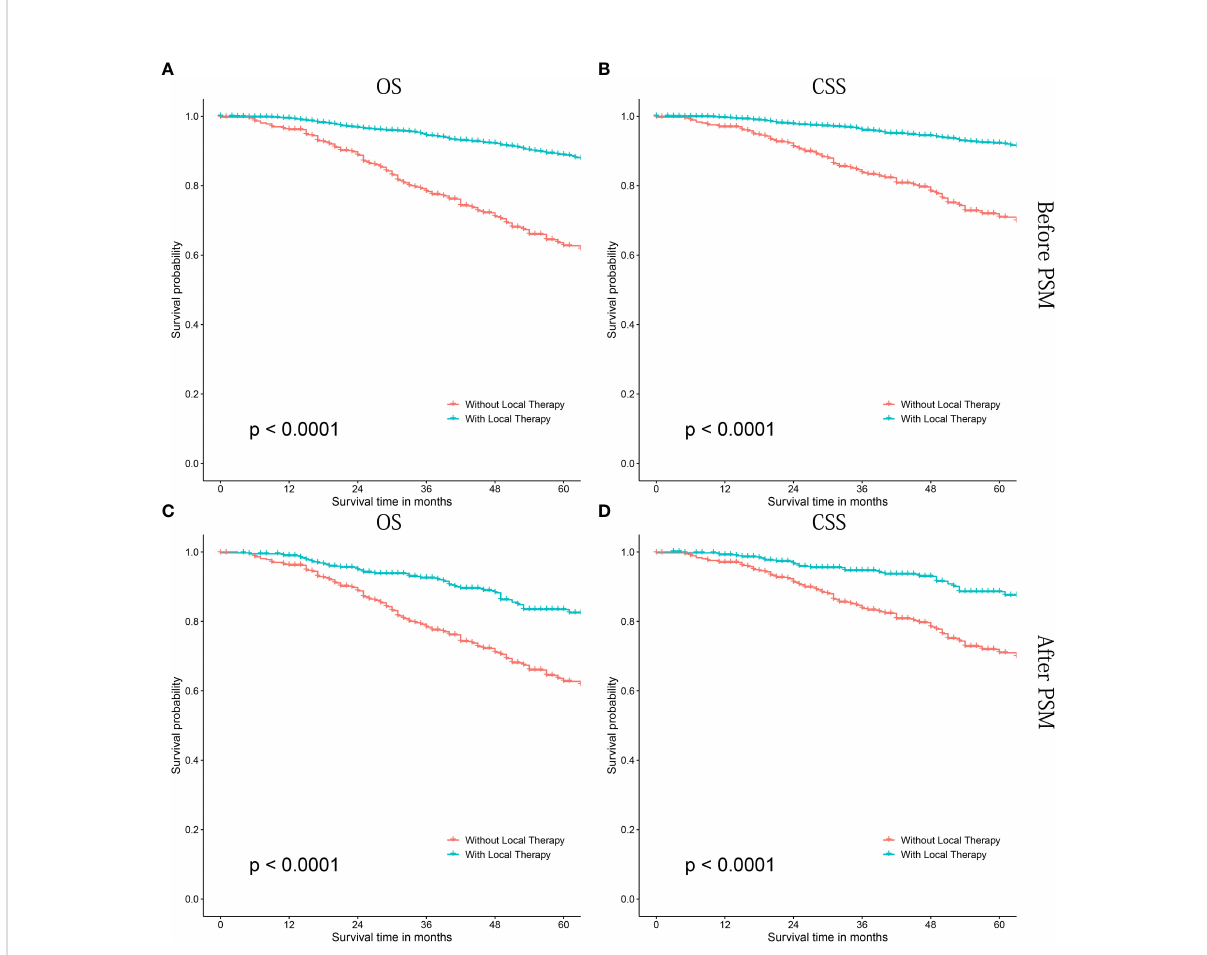
FIGURE 2 Kaplan-Meier survival curves of cN1M0 prostate cancer patients treated with or without local therapy. (A, B) OS and CSS before PSM; (C, D) OS and CSS after PSM. OS, overall survival; CSS, cancer-speci fi c survival; PSM, propensity score